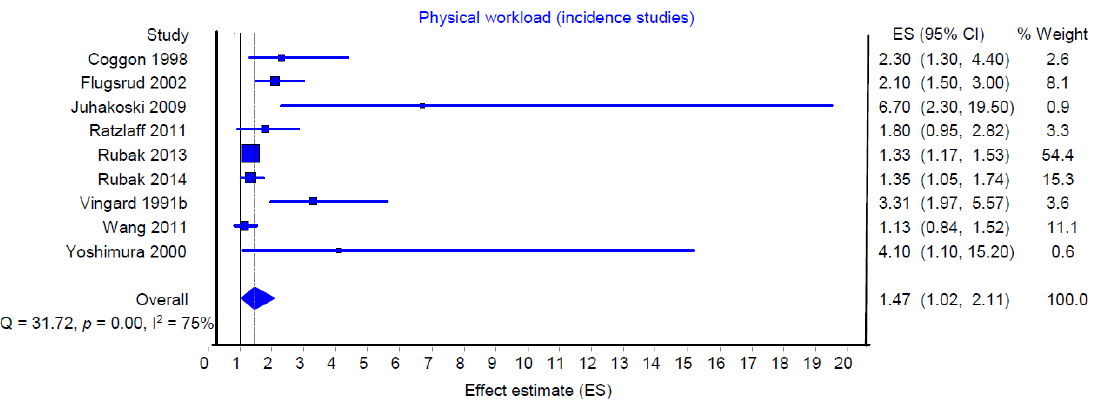
Figure 3. Meta-analysis of heavy physical workload/heavy lifting and the risk of hip osteoarthritis (all incidence studies, n = 9).